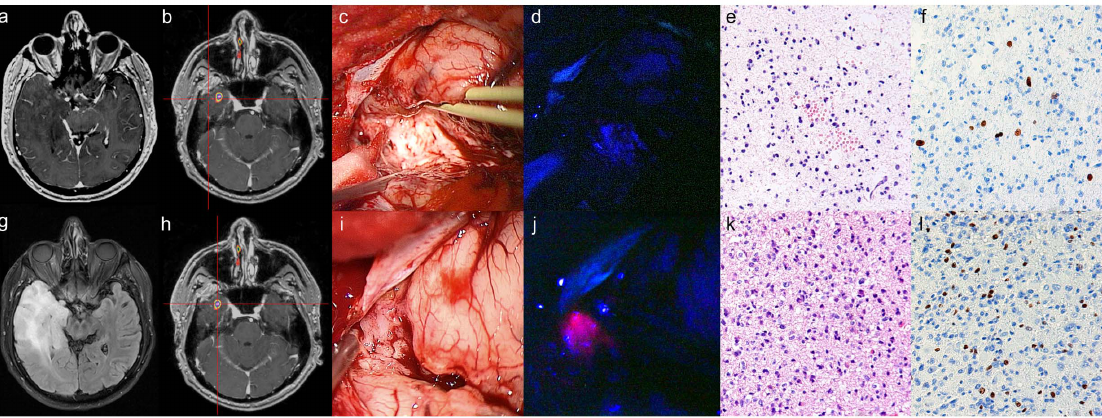
Figure 2. Example of 5-ALA application in a left temporal glioma with non-significant contrast-encencement (CE) on magnetic resonance imaging (MRI). (a) Preoperative contrast-enhanced T1-weighted MR images show patchy/faint CE and (g) hyperintensity on FLAIR sequences. (b) The intratumoral area outside the region of maximum positron emission tomography (PET) tracer uptake verified by the intraoperative navigation system (c) appeared as whitish glioma tissue under the surgical microscope, (d) with no detectable PpIX fluorescence. (e) The corresponding histopathology reveals low-grade glioma tissue according to the WHO criteria in the H&E stain (f) with a low proliferation rate (MIB-1: , 10%). (h) In contrast, the intratumoral area inside the region of maximum PET tracer uptake (i) showed similar glioma tissue appearance in the microscopic view, (j) but revealed strong PpIX fluorescence under violet-blue excitation light. (k) The corresponding histopathology reveals high- grade glioma tissue in accordance with an anaplastic focus according to the WHO criteria in the H&E stain (l) with a high proliferation rate (MIB-1: 32%). The final histopathological diagnosis revealed a focally anaplastic astrocytoma (WHO grade III) and the patient was treated with radiochemotherapy. The width of each histopathological image (e, f, k, l) was 300 micrometers ( m m).